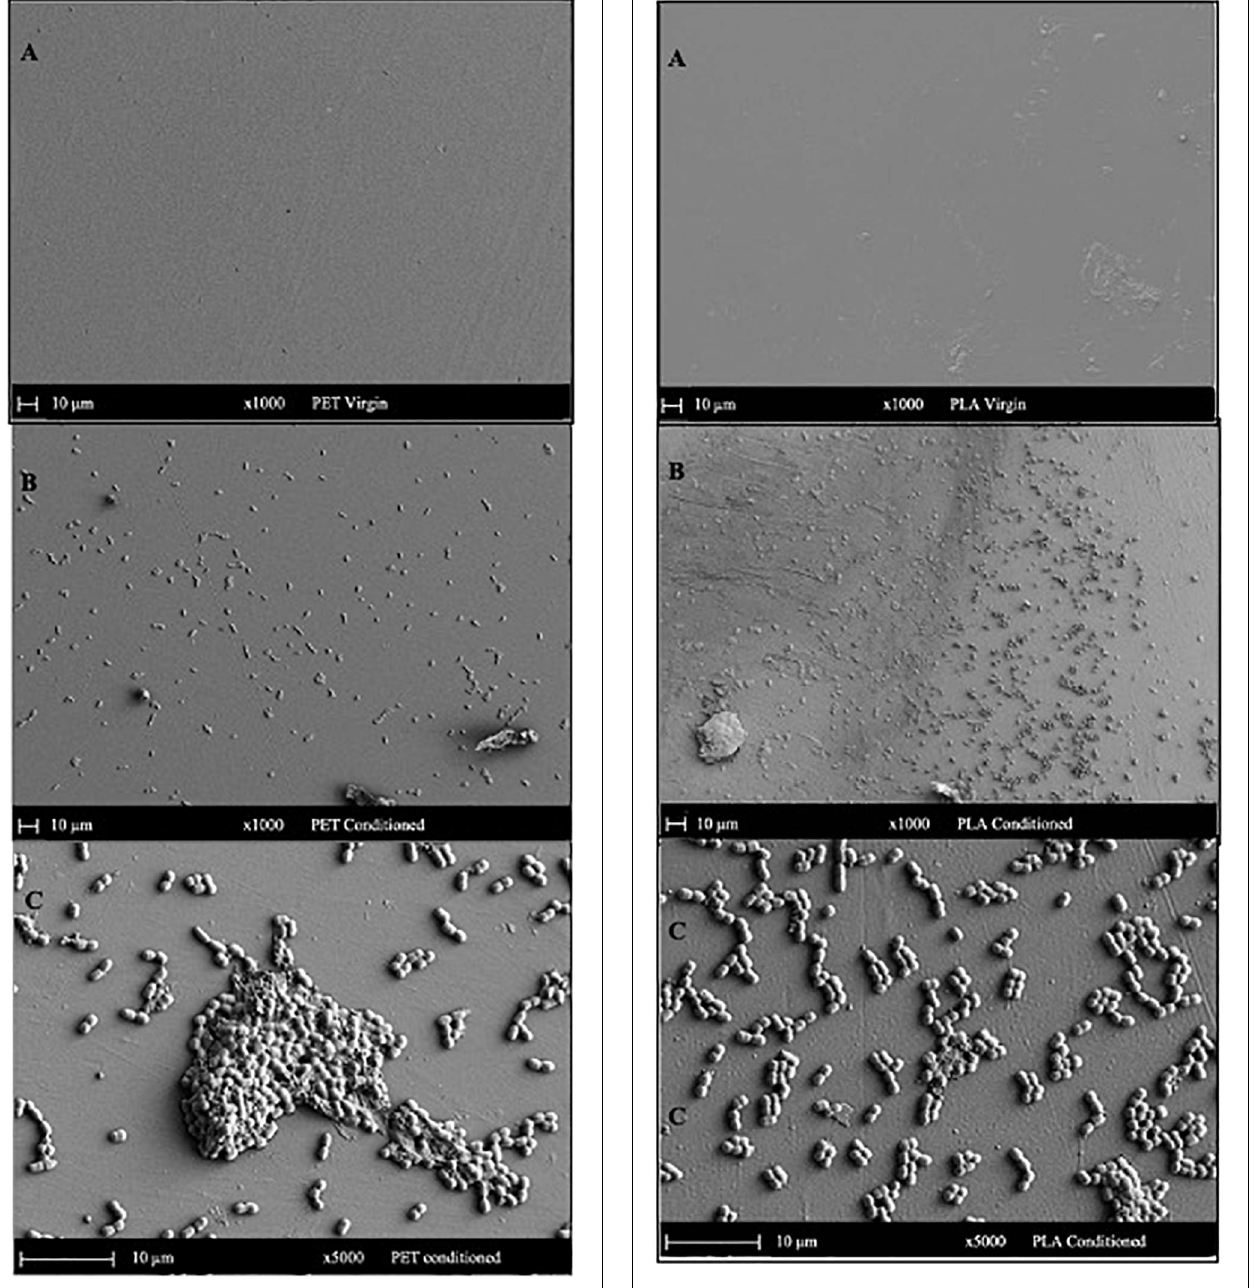
roughness (Sq) of PET and PLA after 24 h immersion in seawater increased by ∼ 11 and 30%, respectively ( Table 1 ).